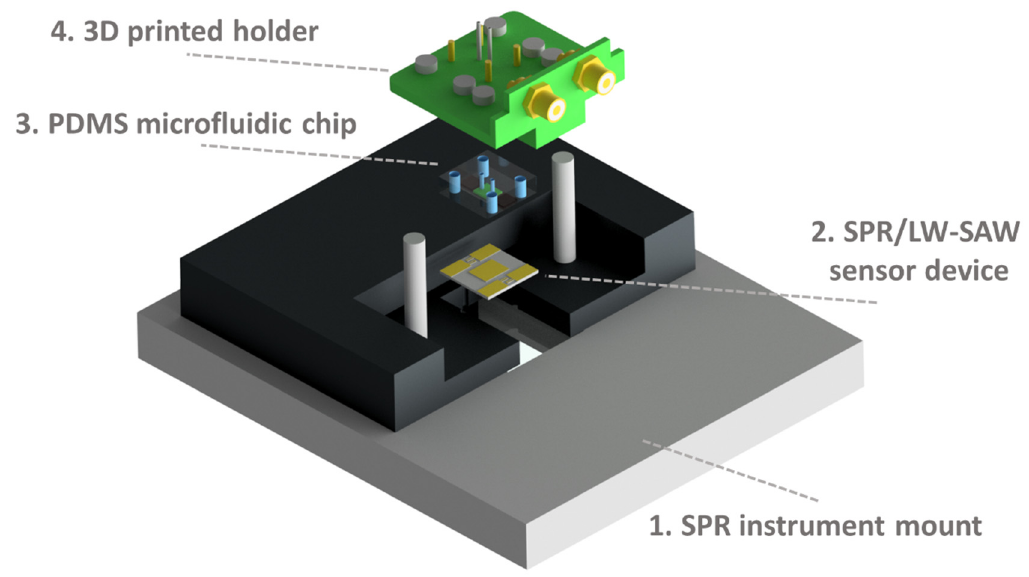
Figure 3. Experimental set-up assembly: First, the SPR / LW-SAW sensor device (2) is placed on the mount of the SPR instrument (1). Then, the PDMS chip (3) is fixed to the 3D-printed holder (4) and applied on the device surface.